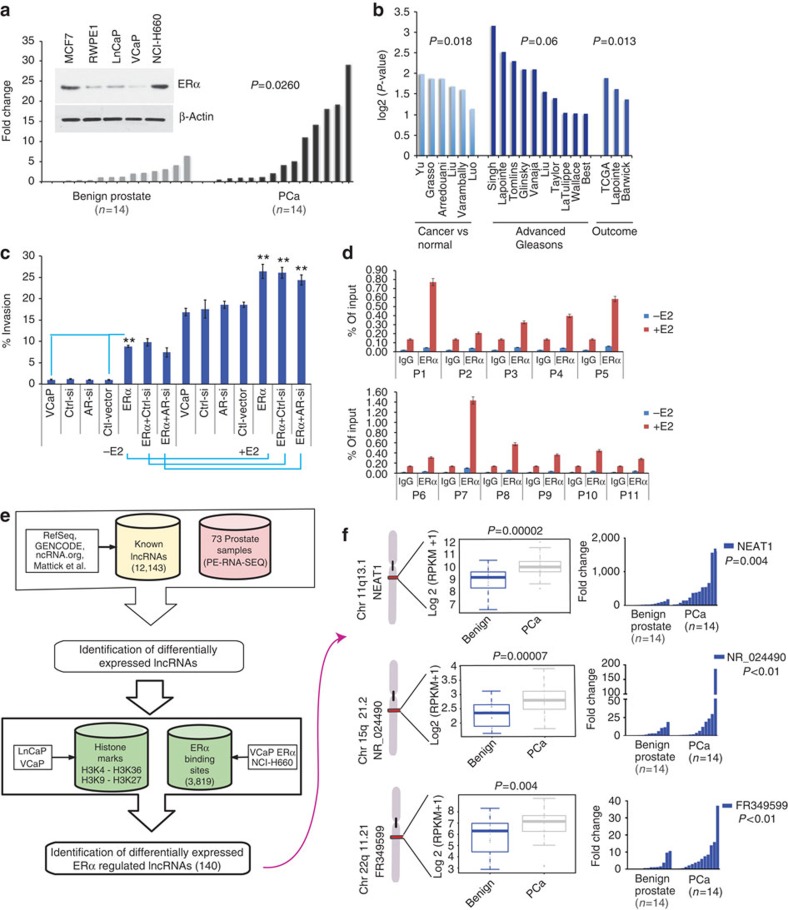
ERα plays a distinct role in prostate cancer.(a) ERα is upregulated in prostate cancer compared with matched benign controls. Waterfall plots depict the qRT-PCR expression levels of ERα mRNA in an independent cohort of benign (n=14) and PCa (n=14). (inset A) The expression of ERα in different prostate cancer cell lines was determined by western blotting and compared with MCF7, a breast cancer cell line. (b) Analysis of ERα expression in Oncomine public data sets of normal versus prostate cancer and advanced disease. (c) Invasion of VCaP and VCaP ERα cells analysed 48 h post treatment with vehicle control or E2 (10 nM) in the presence of control or AR-siRNA. Results are expressed as the mean±s.d. of three independent experiments. Student’s t-test was performed for comparisons (% Invasion) between −E2 and +E2 conditions for ERα, ERα-Ctrl siRNA and AR-siRNA, and **P<0.01 were considered statistically significant. (d) Recruitment of endogenous ERα to target gene chromatin was analysed in VCaP cells with or without E2 treatment. Results are expressed as the percentage of input of two independent experiments. Error bars represent the range of data. (e) Computational pipeline for identification of ERα-regulated lncRNAs upregulated in prostate cancer: a schematic overview of the methodology employed to identify ERα-regulated lncRNAs that are differentially expressed between benign versus prostate cancer and prostate cancer versus NEPC. (f) Box plots show expression levels of the top three ERα-regulated lncRNAs from 26 benign and 40 PCa cases, with ideogram depicting their chromosomal position. Waterfall plots depict the qRT-PCR expression levels on an independent cohort of benign (n=14) and PCa (n=14) of the three nominated lncRNAs: NEAT1, NR_024490 and FR349599.